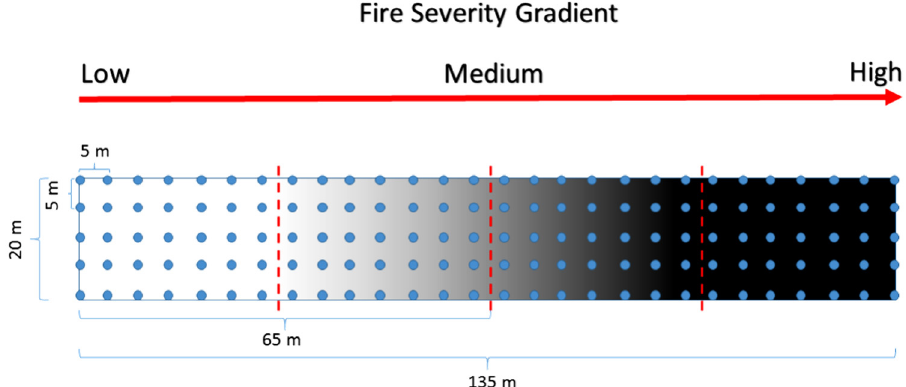
Figure 2. Sampling design for the collection of soil data within a fire severity gradient. The dashed red line indicates the change from one fire severity level to another. The blue dots represent the places where we took soil samples from. Both the red arrow and the gray-shade gradient in the figure indicate the increase in fire severity along the experimental area running from the south to the north.